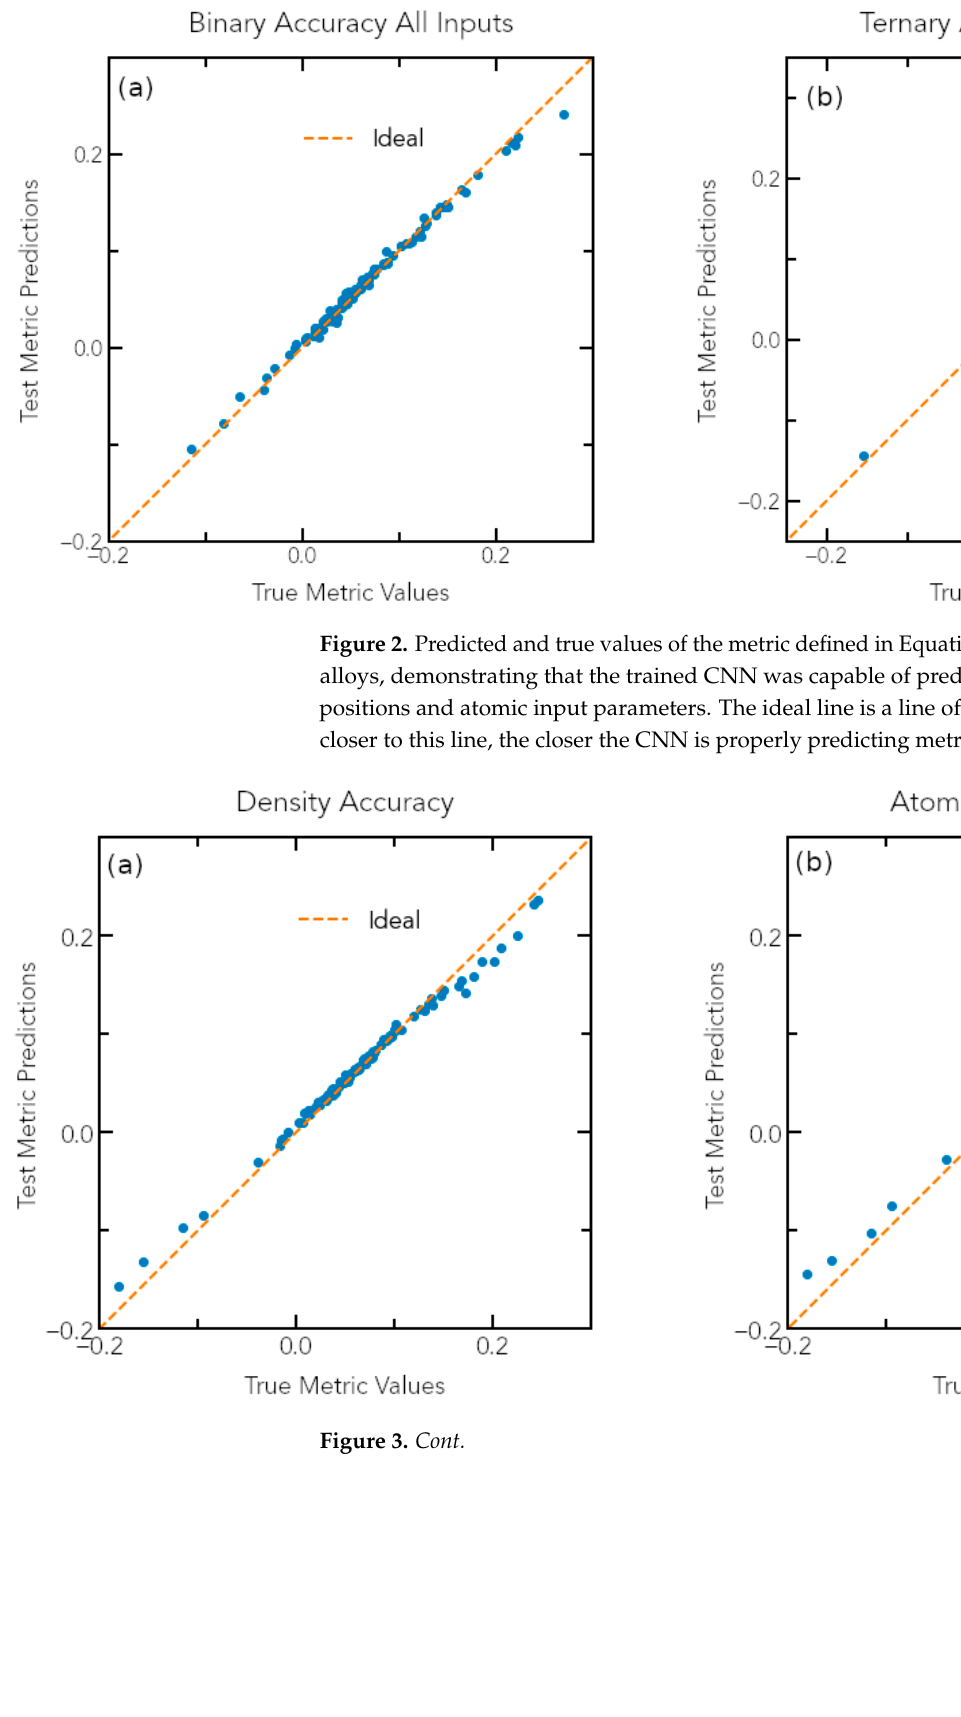
Figure 3. By restricting the input predictors, we were able to determine the atomic parameters that, combined with composition, are necessary for the CNN to effectively predict the metric defined in Equation (7). ( a ) Density only; ( b ) Atomic mass only; ( c ) Density and Atomic Mass; ( d ) Density and Boiling Point. The minimal set to produce predictions as good as the full model requires two pa- rameters, e.g., density and boiling point. The ideal line is a line of slope one and intercept zero—the closer to this line, the closer the CNN is properly predicting metric values. 3.3. Candidate Superconductors to Enhance QISE The salient metric for QISE applications is the achievable coherence time (T 2 ) of a full device. This depends not just on the interfaces and oxides, but also on other parameters of the superconducting state. The critical temperature, T c , is particularly important, as de- vices should be operated at T << T c in order to suppress fluctuations that are detrimental to T 2 . We thus constructed the overall plot shown in Figure 4, which plots oxidation metric